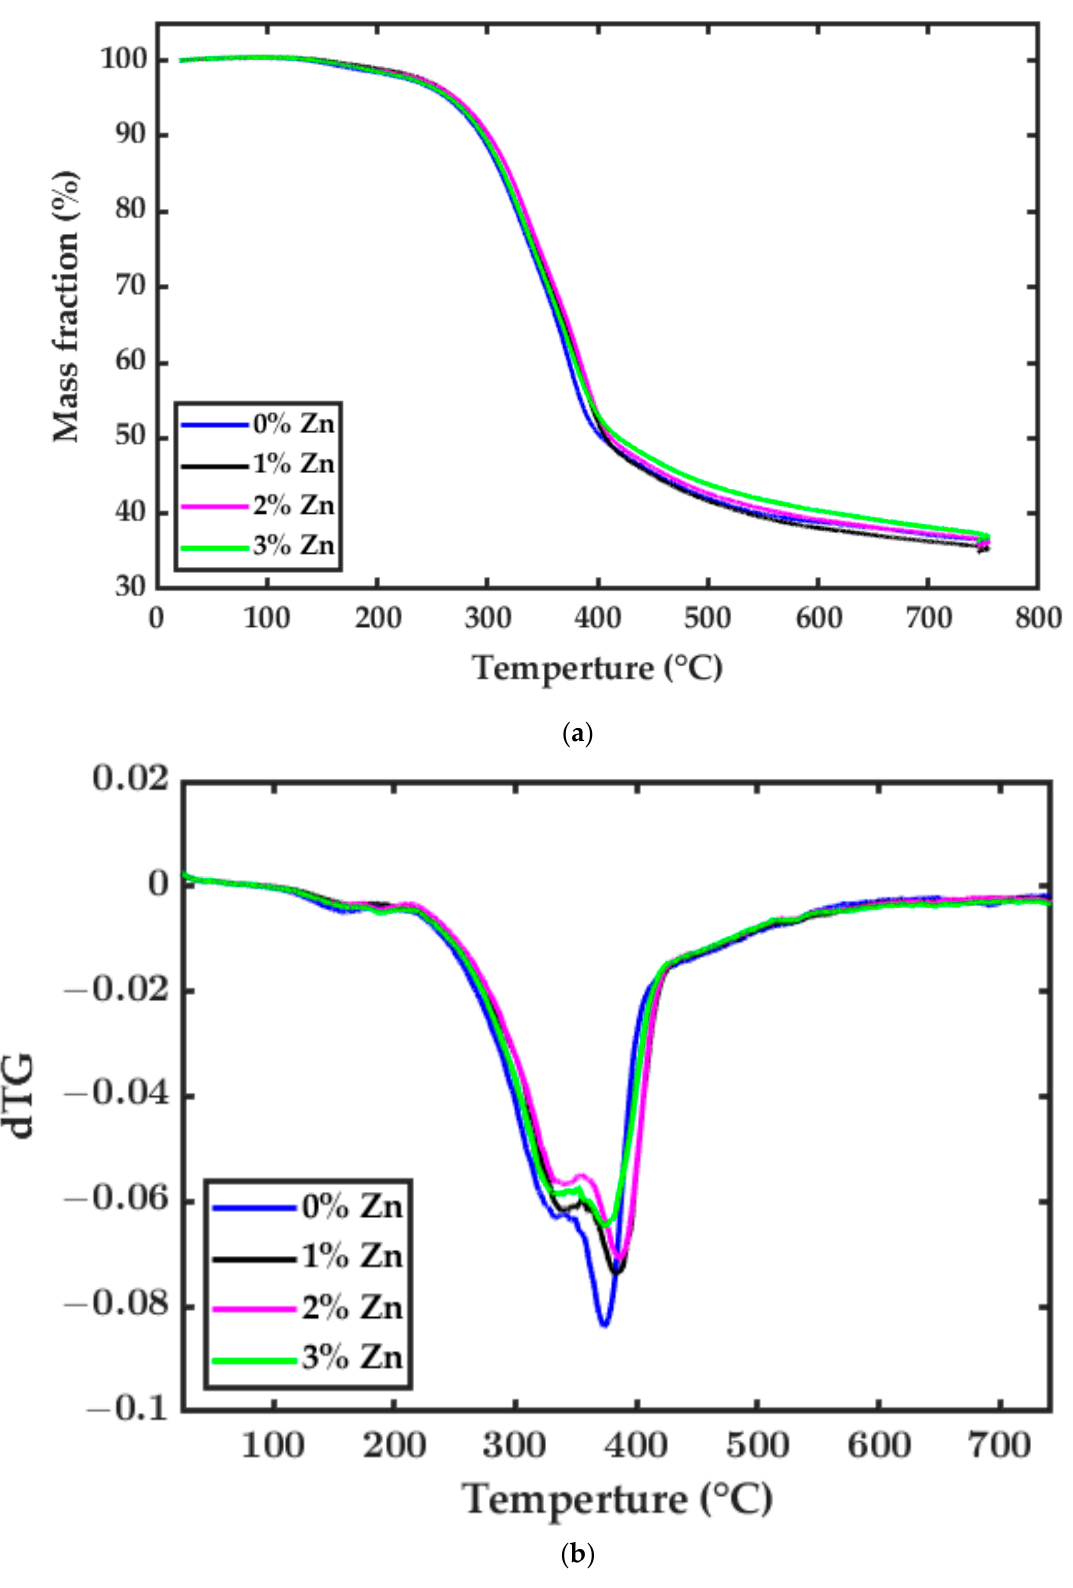
Figure 3. EFB at 50 K/min heating rate: ( a ) Mass loss curve for samples with 0%, 1%, 2%, and 3% catalyst. ( b ) DTG curves for samples with 0%, 1%, 2%, and 3% catalyst. In Table 2, the carbonization percentages of the samples and the mass loss during the pyrolysis reaction were related. In addition, Table 3 shows the temperatures at which the 50% mass loss was reached.